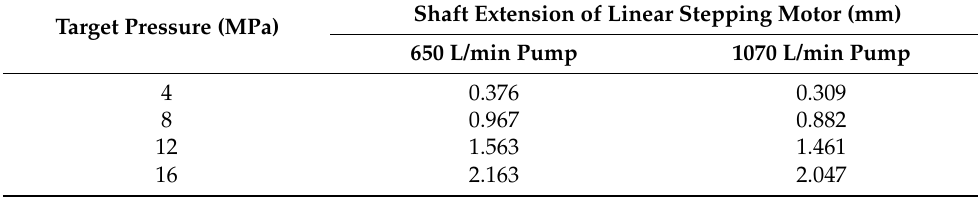
Table 4. Prediction of shaft extension of linear stepping motor.